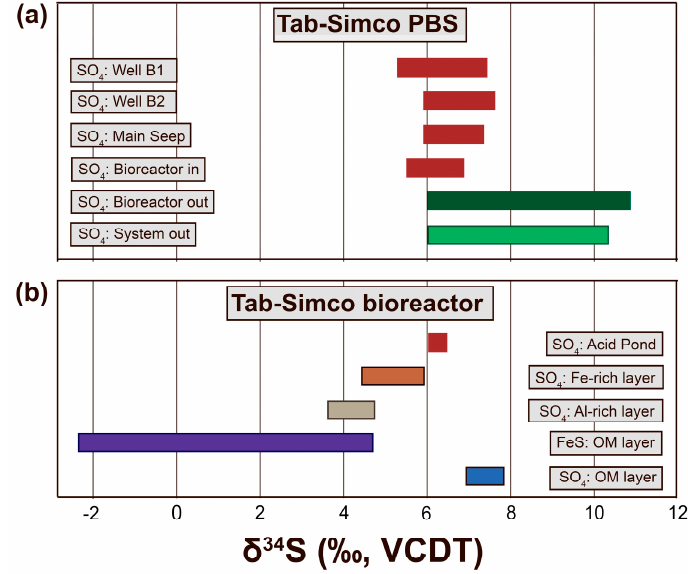
Figure 9. Ranges of sulfur isotopes values of ( a ) dissolved sulfate (SO 42 − ) in water samples collected at different sampling points across the Tab-Simco PBS; and ( b ) dissolved and solid sulfur fractions from the Tab-Simco bioreactor collected in August 2013 when the bioreactor media was replaced.